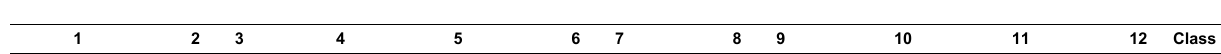
Table 2. Features of two patterns in the same